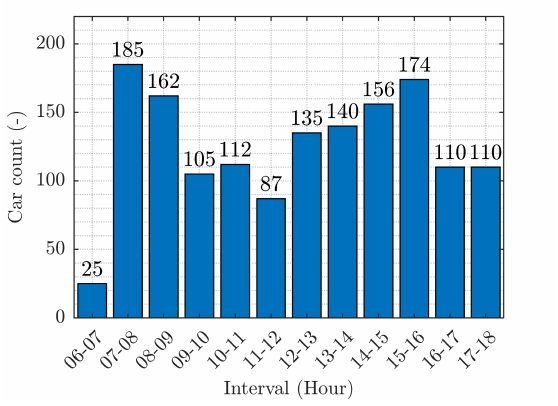
Figure 10. Traffic density at the main entrance to the VSB-TUO site between 06:00 and 18:00. Traffic density measurements for passing cars were analyzed using binary classification (whether a significant point falls under True Positive (TP), False Positive (FP) or False Negative (FN)) [32]. By determining TP, FP and FN, the Sensitivity (SE), Accuracy (ACC), Positive Predictive Value (PPV), Harmonic Means of Precision and Sensitivity (F1) and False Negative Rate (FNR) can be calculated